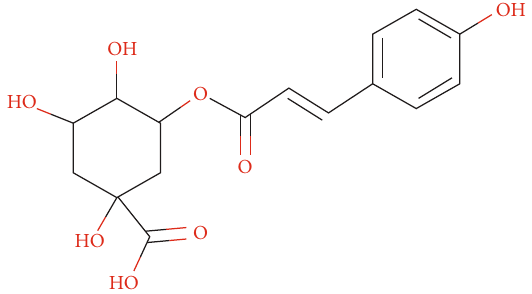
Figure 5: Molecular structure of p-coumaroylquinic acid (C H O ; MW = 338 : 31g/mol 16 18 8